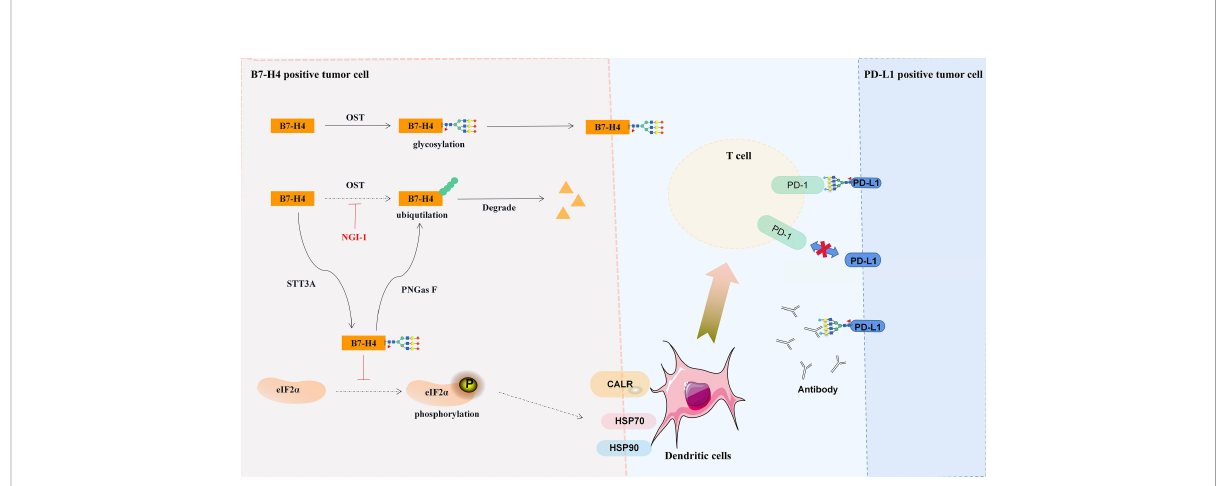
FIGURE 3 Regulation and signi fi cance of B7-H4 glycosylation. Glycosylated B7-H4 inhibits the phosphorylation of eIF2 a and dendritic cell recruit, and deglycosylation lead to the ubiquitination and degradation of B7-H4. CALR, calreticulin; HSK70, heat shock protein 70; HSK90, heat shock protein